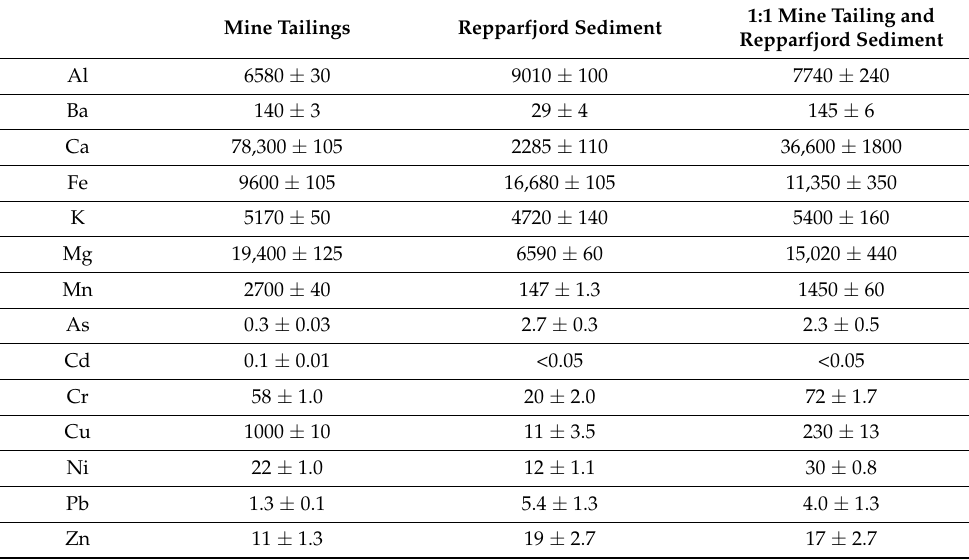
Table 2. Metal concentrations (mg/kg TS) in the mine tailings with data from [31], Repparfjord sediment, and the mixture of mine tailings and the Repparfjord sediment, used in the leaching